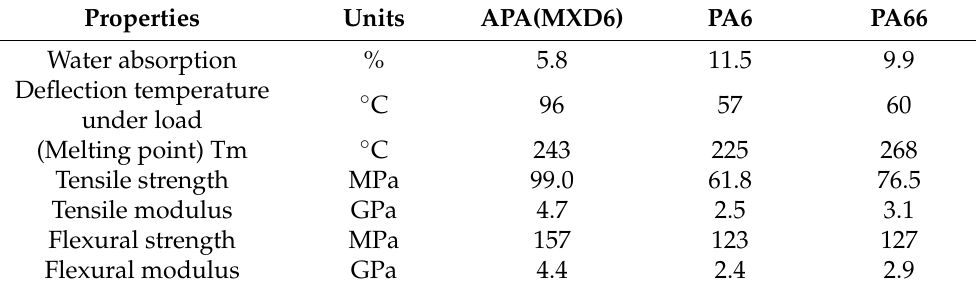
Figure 1. Comparison of molecular structures ( a ) aromatic polyamide (APA)(MXD6) and ( b ) Polyamide 6,6. Table 1. Comparison of properties of APA(MXD6) and conventional polyamide (PA)